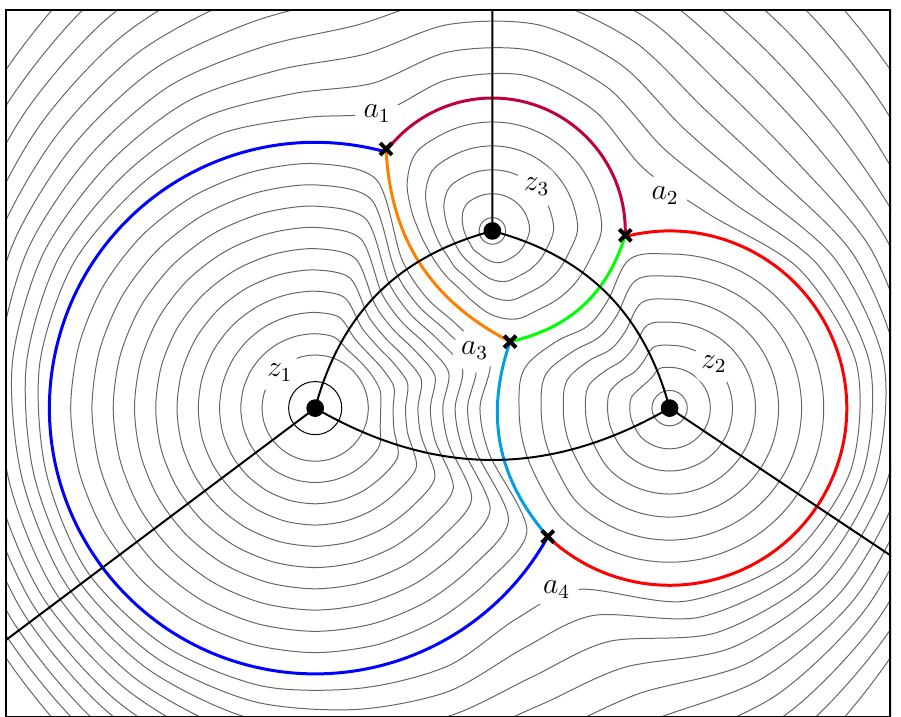
Figure 1 . The grey lines are the horizontal trajectories of a Strebel differential, see eq. (6.4), while the coloured lines describe the critical horizontal trajectories that make up the critical Strebel graph, see section 6 for more details. The (double) poles z of the Strebel differential are denoted i by black dots ( z = ∞ ), while the zeros a are represented by black crosses, see eq. (1.5). Finally, 4 i the solid black lines between the poles describe the dual edges to the critical Strebel graph, and therefore correspond to the edges of the skeleton graph of the field